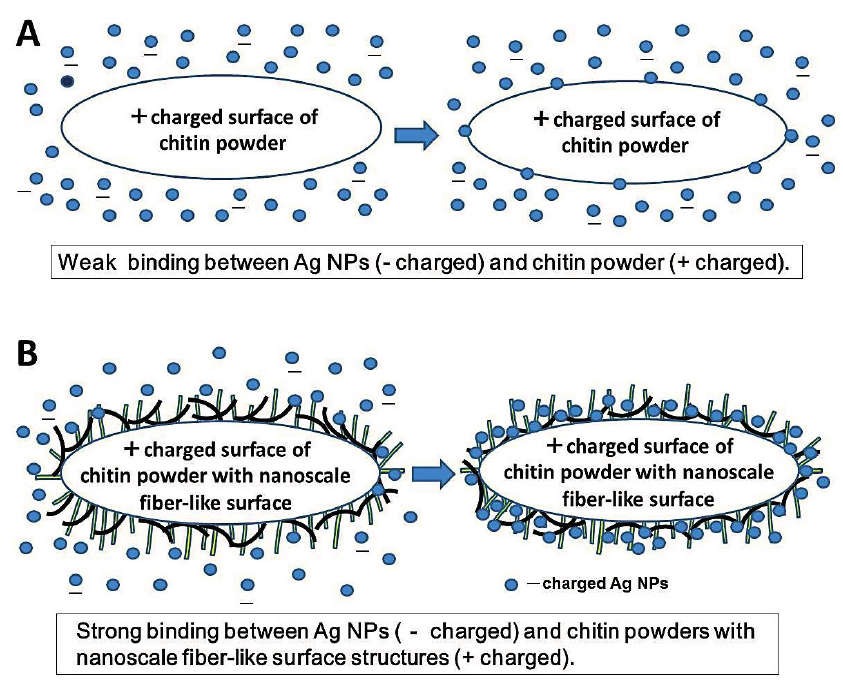
Figure 4. Scheme on adsorption of Ag NPs onto chitin with flat/smooth film-like surface structures ( A ) with nanoscale fiber-like surface structures ( B ).